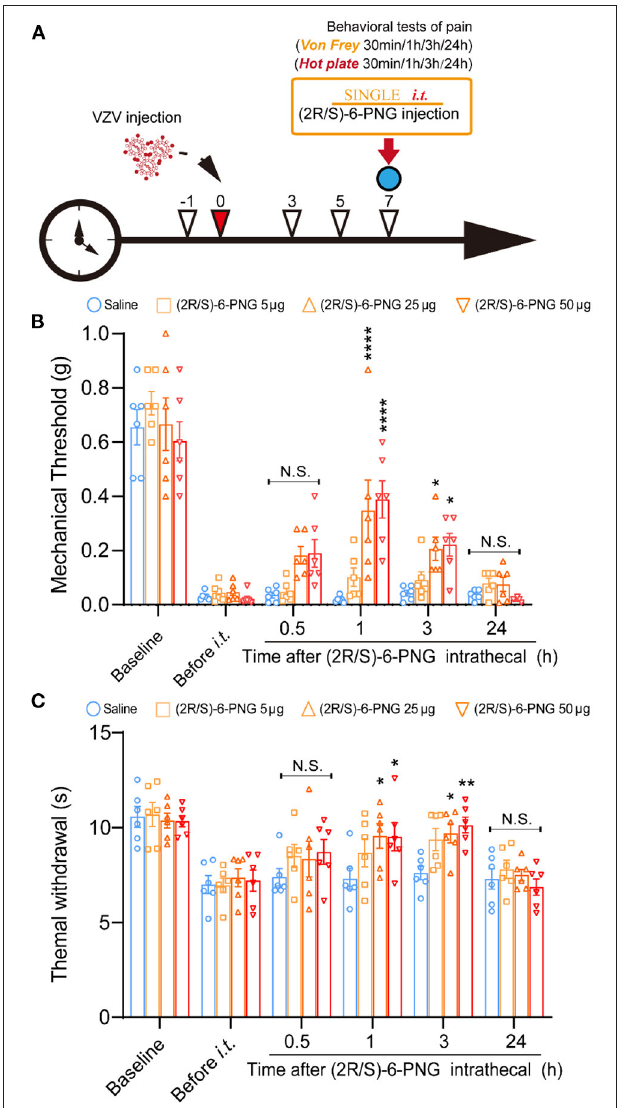
FIGURE 3 | Intrathecal injection of (2R/S)-6-PNG (Cav3.2 inhibitor) alleviated mechanical and heat hyperalgesia in postherpetic neuralgia (PHN) mice. (A) Schematic operation process. VZV was inoculated into the footpad of male mice on day 0, then intrathecal injection of (2R/S)-6-PNG was performed on day 7 after VZV inoculation. Mechanical and heat hyperalgesia before and after VZV inoculation, 0.5, 1, 3, and 24h after (2R/S)-6-PNG injection were tested with von Frey filaments and a hot plate. (B) Alleviated mechanical hyperalgesia occurred in 1 and 3h after (2R/S)-6-PNG (25 and 50 µ g) injection. (C) Alleviated heat hyperalgesia occurred in 1 and 3h after (2R/S)-6-PNG (25 and 50 µ g) injection. * p < 0.05, ** p < 0.01, **** p < 0.0001 compared with the saline group at the corresponding time; NS, not significant; it , intrathecal; n =